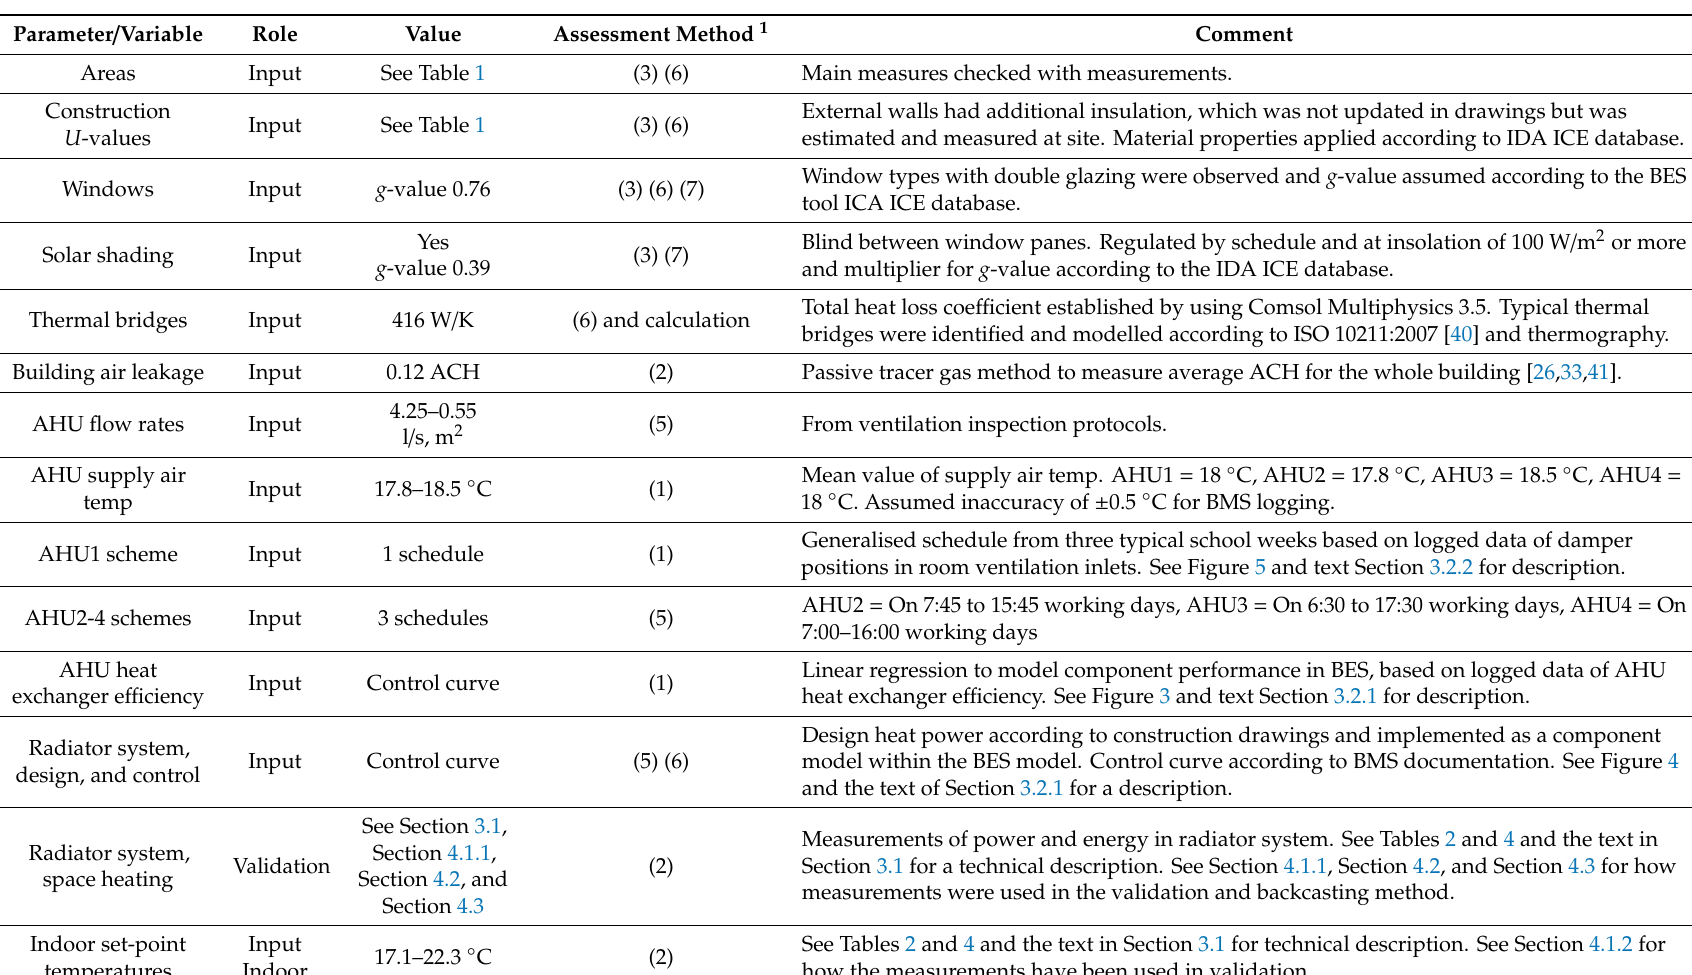
Table 5. Input and validation data overview. Values, source of collected data, and